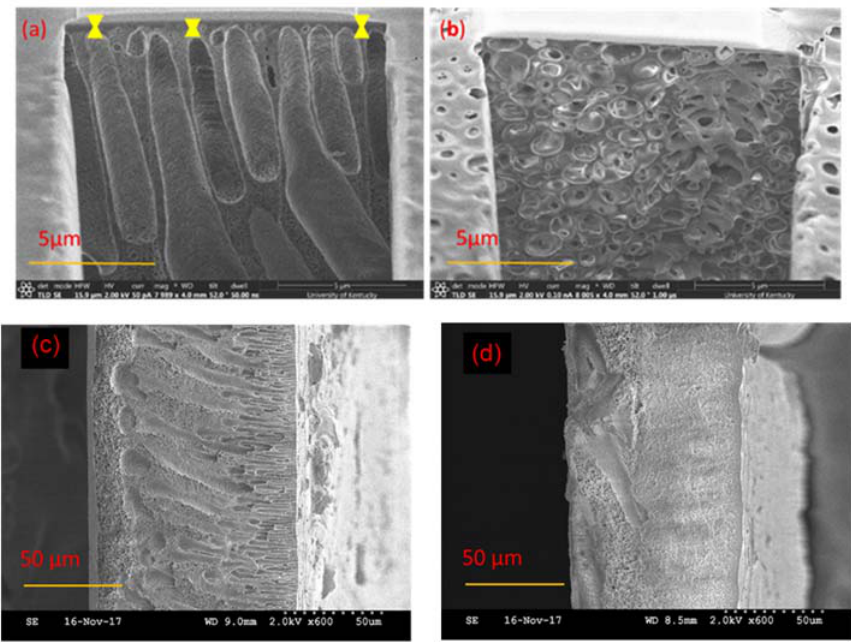
Figure 7. Cross-sectional FIB-SEM images of the top layers of PSf ultrafiltration membranes prepared with: ( a ) DMAc; ( b ) PolarClean. Cross-sectional SEM images of PSf ultrafiltration membranes prepared with: ( c ) DMAc; ( d ) PolarClean.